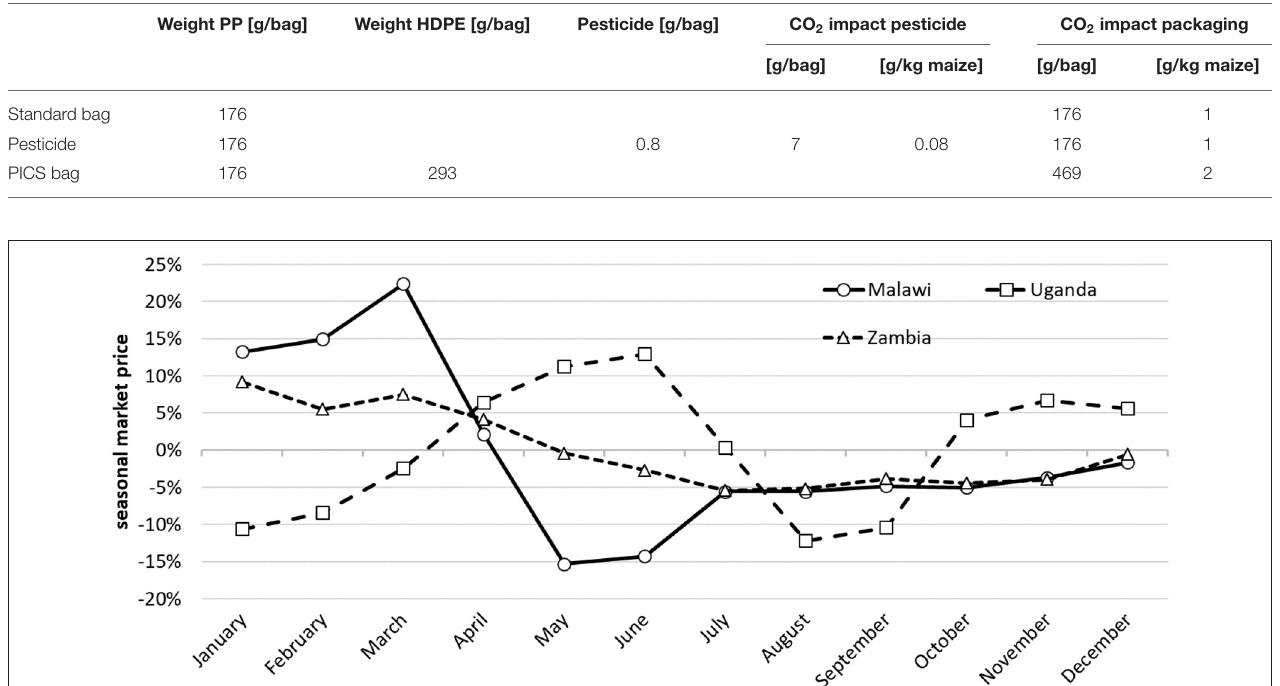
FIGURE 1 | Seasonal price fluctuations of maize, below and above the average year price (30 $c/kg maize) in different countries, data from (Gilbert et al., 2017; Kornher, 2018).